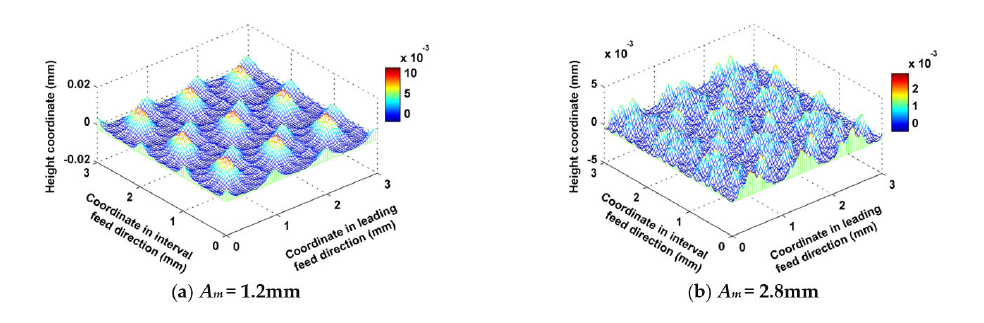
Figure 12. Ball-end milling micro surface topography comparison between different amplitudes of the